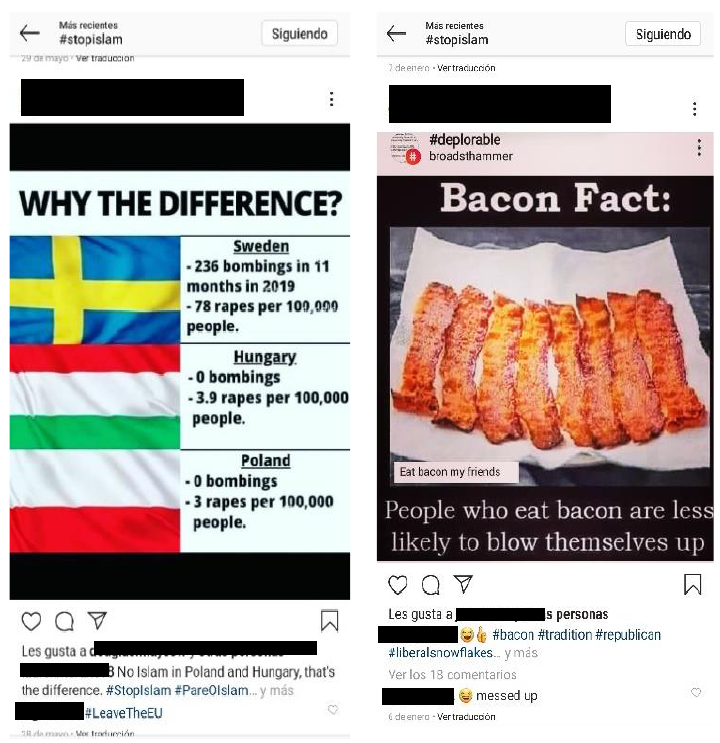
Figure 4. Examples from the category Muslims are terrorist.